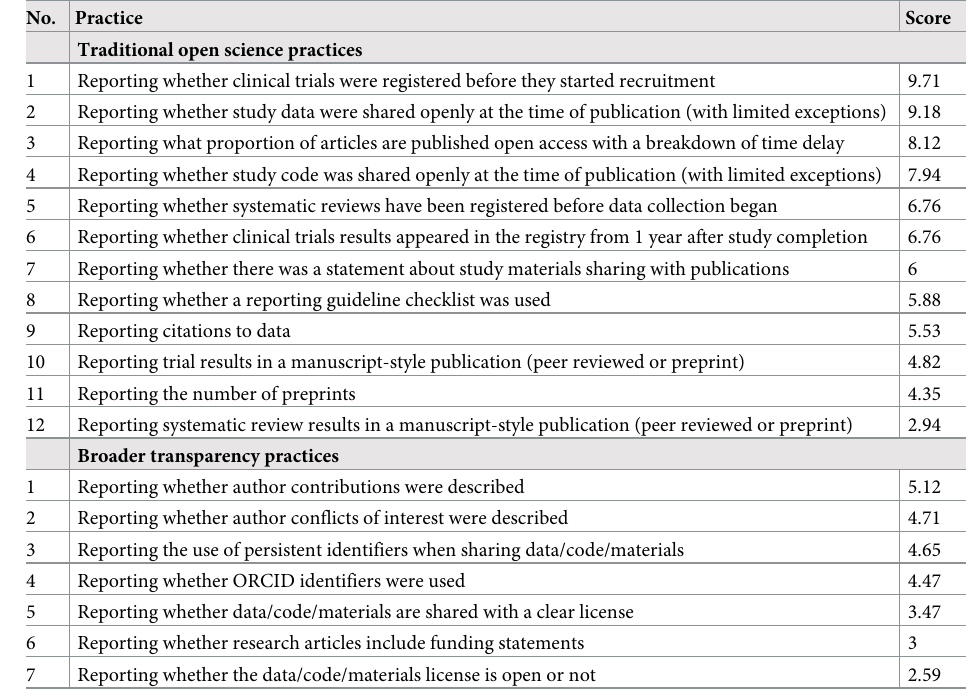
Table 3. Prioritization of traditional open science practices and broader transparency